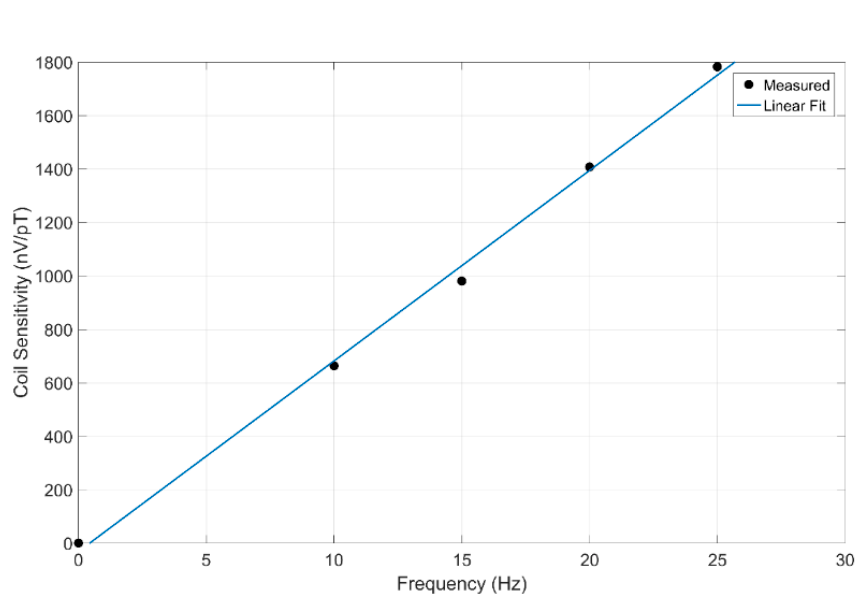
Figure 8. Measured magnetic coil (antenna) sensitivity against frequency along with the corresponding best linear fit line.